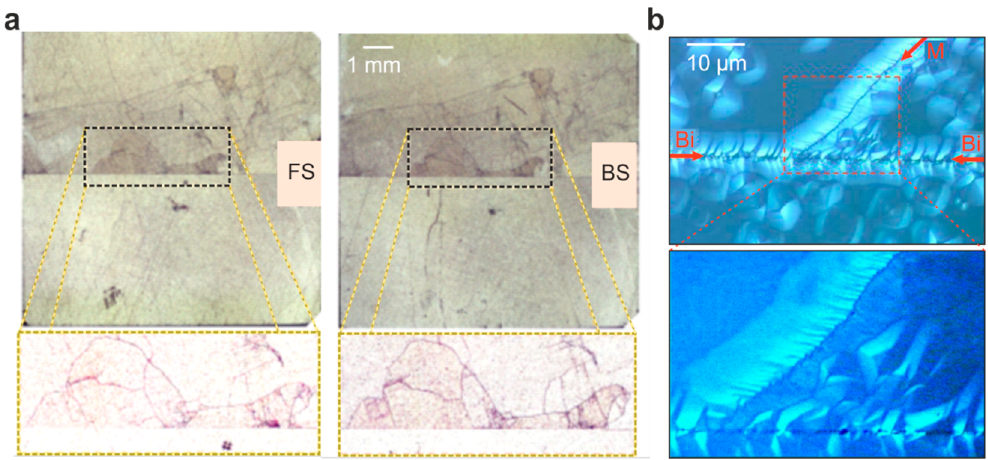
Figure 2. Distribution of dislocations in a “real” 36.8° bicrystal. ( a ) Optical micrographs of the front side (FS) and backside (BS) after HF etching (the BS image was mirrored for the sake of comparability); ( b ) Micrographs obtained close to the bicrystal boundary (Bi) with the mosaic structure (M) indicated. The blue coloration of the images results from the optimization of the differential interference contrast. Adapted from Szot et al. [14].